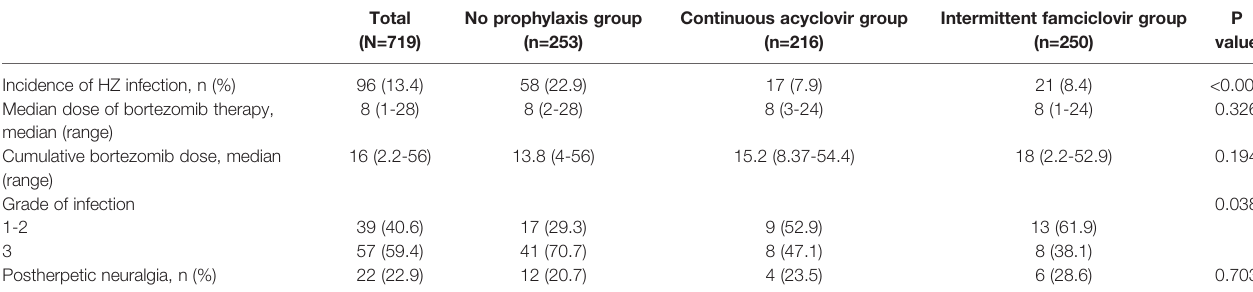
TABLE 2 | Characters of VZV reactivation.